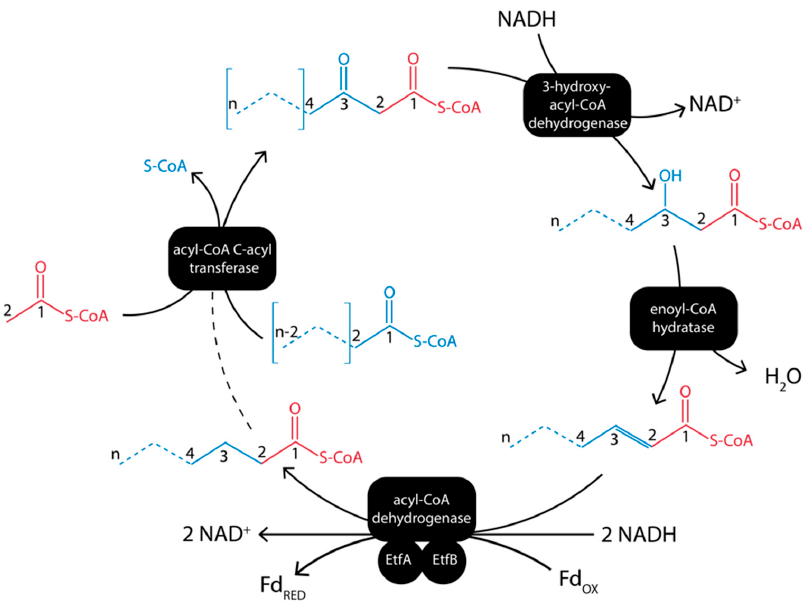
Figure 2. Reverse β -oxidation with an electron-bifurcating acyl-CoA dehydrogenase.